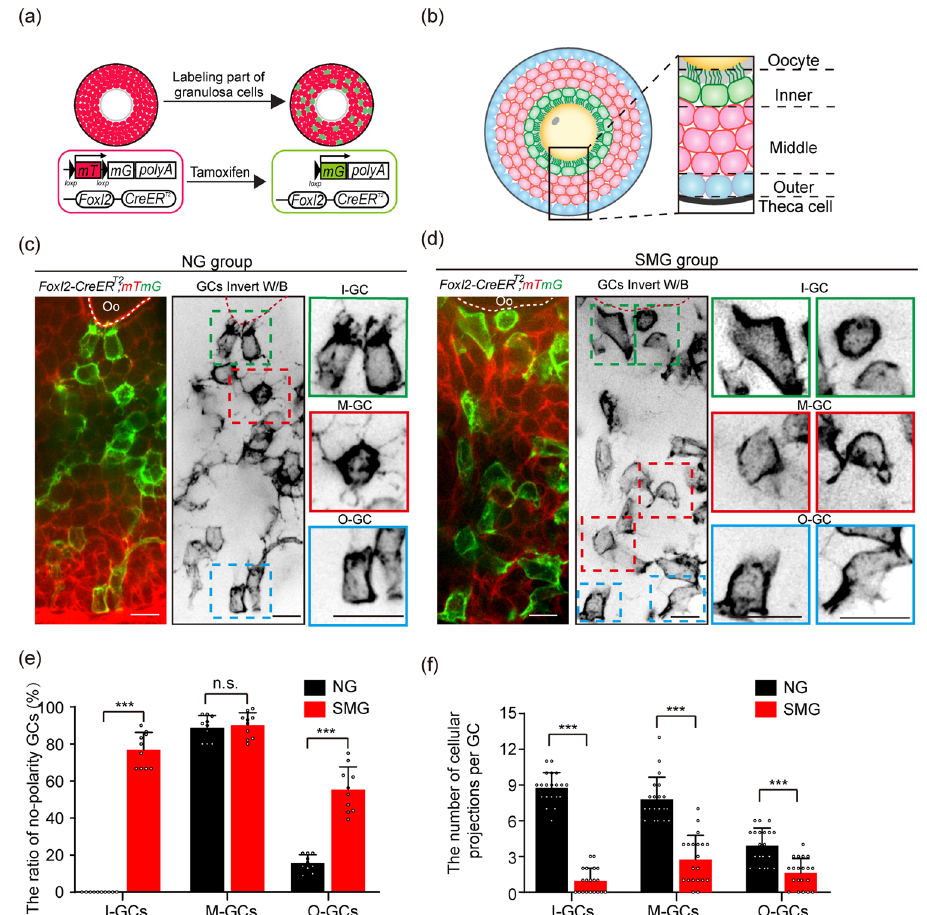
Fig. 3 SMG treatment disrupted GC polarity and the formation of communicating structures in GCs. a Illustration of the strategy to induce labeling of the GCs in Foxl2-CreER T2 ;mTmG follicles. With a low dosage of tamoxifen treatment, membrane-localized red fl uorescent protein (mT) switches to green- fl uorescent protein (mG) in GCs of Foxl2-CreER T2 ;mTmG follicles, which allows for imaging of the cell outline of GCs under high-resolution imaging system. b The standard to separate the GCs in growing follicles. The inner layer of GCs was de fi ned as the layer which directly connected to the oocyte by GC-TZPs (I-GCs, green); the middle layers of GCs was distributed in the middle multilayers position of follicle (M-GCs, pink); The outer layer of GCs was de fi ned as the layer adjacent to the theca cells (O-GCs, blue). c Images of Foxl2- CreER T2 ;mTmG follicles showing the morphology of GCs in different regions in the NG group. I-GCs (green box) exhibited cuboidal shape with tree root-like GC-TZPs oriented toward the oocyte. Rounded M-GCs (red box) exhibited extended random cellular projections. Similar shaped cell with I-GCs, cuboidal O-GCs (blue box) extended a few cellular projections toward to M-GCs. Scale bars, 15 μ m. d In the SMG group, both the polarity and the communicating structures on GCs were abnormal, showing a failure of GC-TZPs on I-GCs (green boxes), and dramatically reduced cellular projections on M-GCs (red boxes) and O-GCs (blue boxes). I-GCs and O-GCs exhibited a loss of polarity shape under SMG condition compared to that in the NG group. Scale bars, 15 μ m. The cartoon model as shown in Supplementary Fig. 3. e Statistical analysis of GCs showing a signi fi cant increase in the proportion of non-polarity in I-GCs and O-GCs under SMG conditions ( n = 10) compared to the NG group ( n = 10). I-GCs: p value = 0.0000000010, M-GCs: p value = 0.64, O-GCs: p value = 0.00000082. f Loss of cellular projections in all layers of GCs under SMG conditions ( n = 20) compared to that in NG conditions ( n = 20). I-GCs: p value = 0.00000000000000000000064, M-GCs: p value = 0.00000000059, O-GCs: p value = 0.0000051. Representative images are shown. Data are presented as the mean ± SD. Data were analyzed by two-tailed unpaired Student ’ s t -test and n.s. P ≥ 0.05, *** P < 0.001. The colors were inverted to black/white (b/w) to highlight GCs in ( c , d